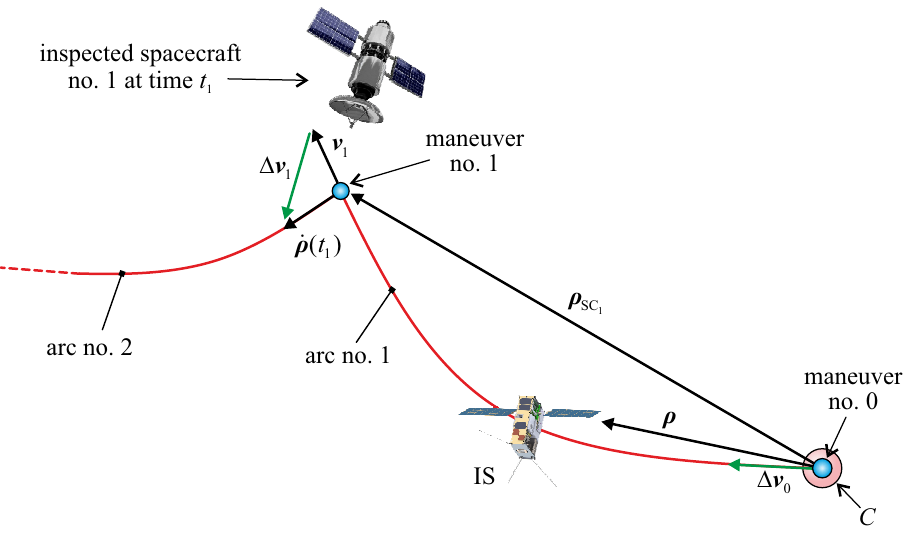
Figure 5. Impulsive maneuvers at the first and second